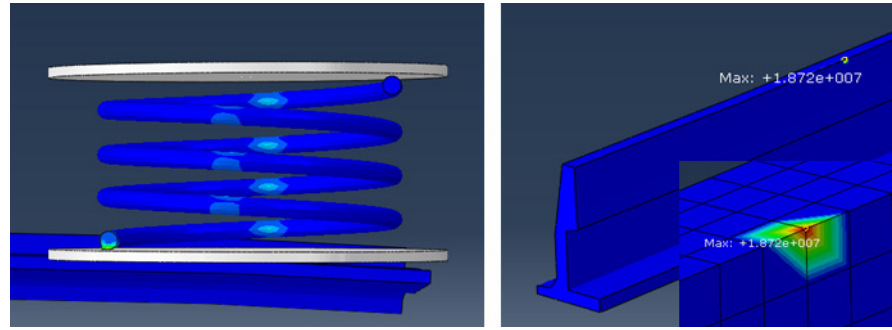
Figure 4. Contact pressure on the initial impact (5 km/h).